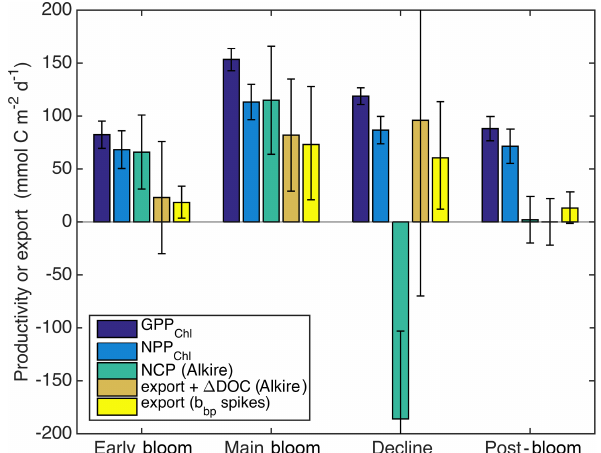
Figure 10. Estimates of sources and sinks of organic carbon inte- grated over the top 60m: GPP Chl a and NPP Chl a and sinking par- ticle export (this study), as well as NCP and loss due to the sum of sinking particle export and net DOC production and sinking parti- cle export only (Alkire et al., 2012). Bloom periods follow Alkire et al. (2012) and are defined in the text (Sect. 3.3).